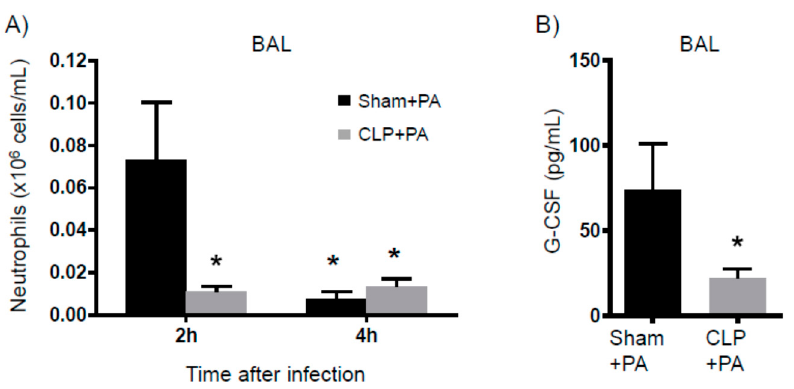
Figure 7. BAL analysis in response to pulmonary infection one week after CLP. Mice were subjected to either sham surgery or CLP. Eight days later, all mice were inoculated with 10 6 CFU of Pseudomonas aeruginosa intranasally. Flow cytometry was then used to evaluate the ( A ) BAL neutrophil numbers 2 hours (sham N = 8, CLP N = 13) and 4 hours (sham N = 14, CLP N = 20) after inoculation ( B ) G-CSF levels were then determined 2 h after inoculation when bacterial burdens were the same (sham N = 6, CLP N = 10). * p < 0.05 compared to sham at 2 h. There was no difference between sham + PA and CLP + PA at the 4-h time point.